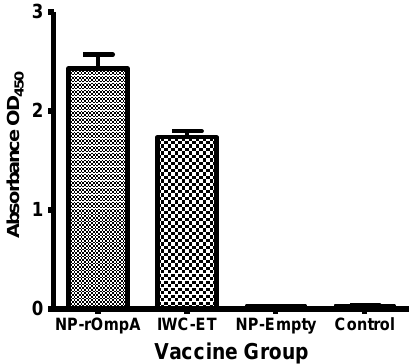
Figure 6. Antibody levels detected against E. tarda from fish vaccinated with the NP-rOmpA, IWC-ET, NP-Empty, and control groups at 51 dpv. Antibody levels from fish vaccinated with the NP-rOmpA were higher than antibody levels from those vaccinated with the IWC-ET vaccine. A significant difference ( p < 0.0003) in antibody levels was detected between the NP-rOmpA and IWC-ET vaccinated groups. The NP-Empty and control groups did not show detectable antibodies against E. tarda at 51 dpv.